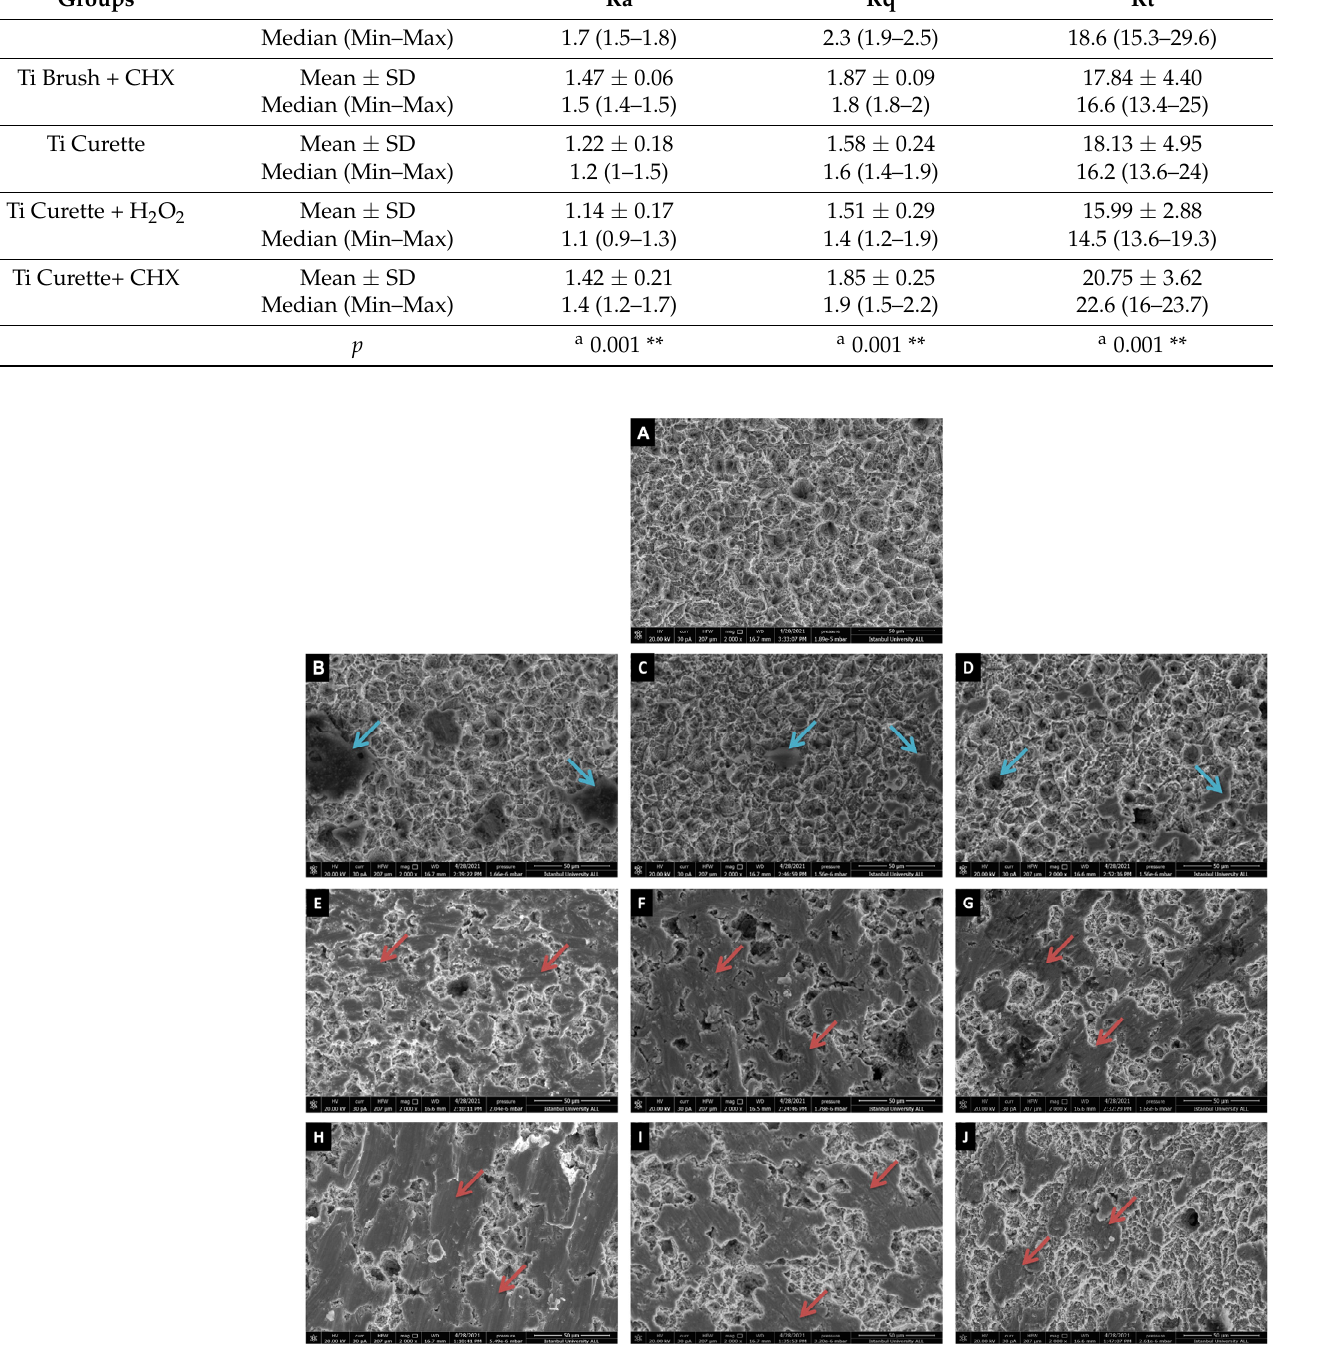
Table 2. Variation and initial statistical analysis of surface roughness values of Ti post decontami-